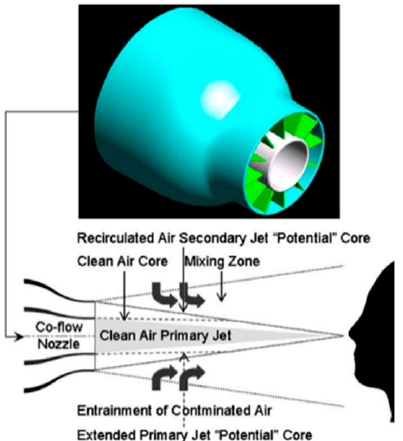
Figure 14. Nozzle with concentric holes [144].